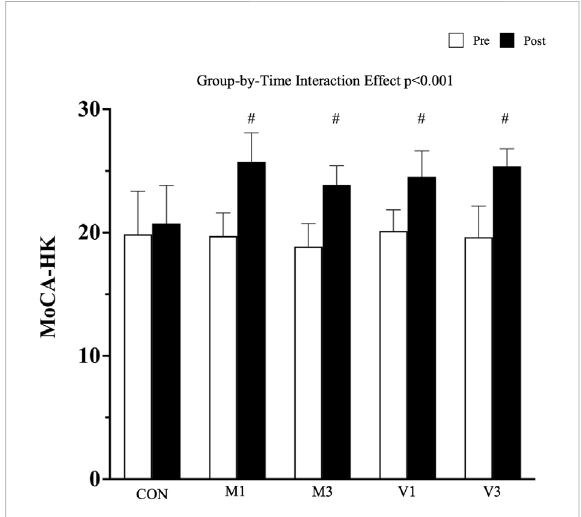
FIGURE 2 Global cognitive Performance Measured by HK-MoCA.